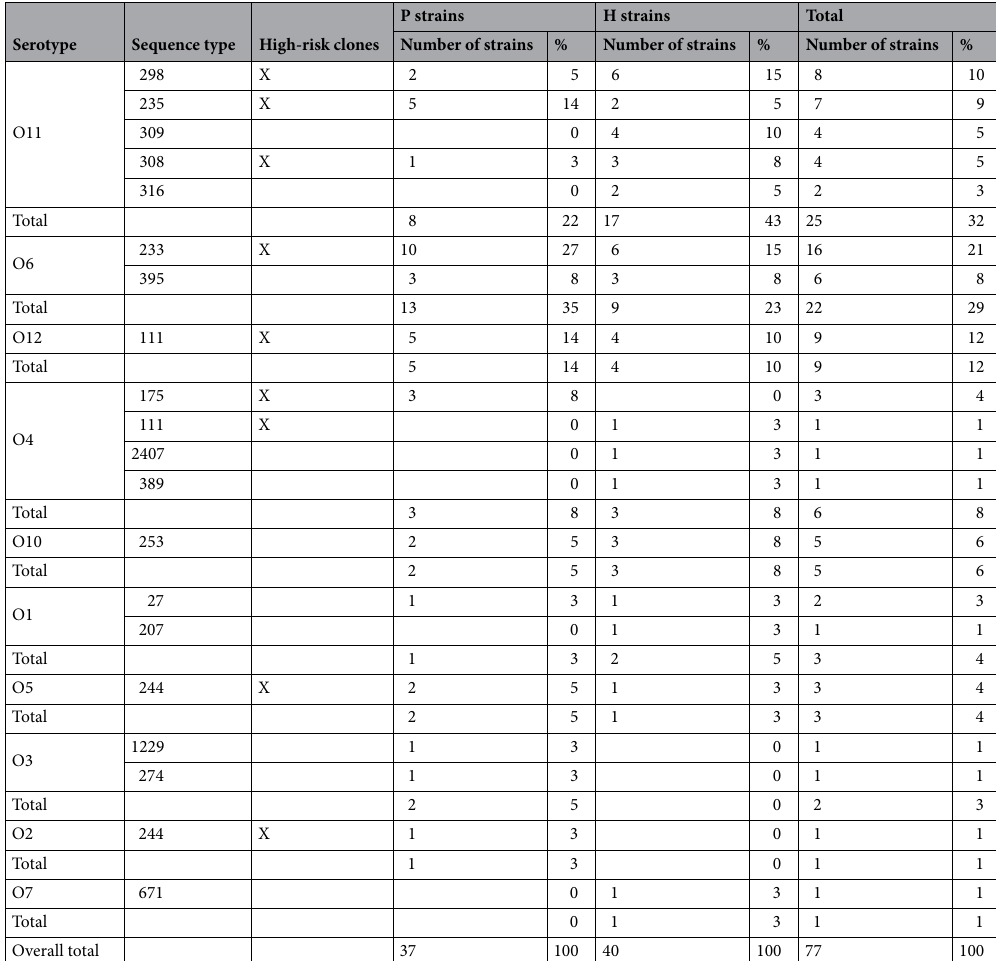
Table 2. Serotyping and multilocus sequence typing (MLST) of 77 sequenced strains constituting the panel for genomic characterization. X, Sequence types considered as the global top 10 P. aeruginosa high-risk clones based on prevalence, global spread, and association with MDR/XDR profiles and regarding extended-spectrum β-lactamases and carbapenemases 31 ; H, Strains isolated from the hospital environment; MLST, Multi locus sequence typing; MDR, Multidrug-resistant; XDR, Extensively drug resistant; P, Strains isolated from patients; VIM-2, Strains producing the class B carbapenemase